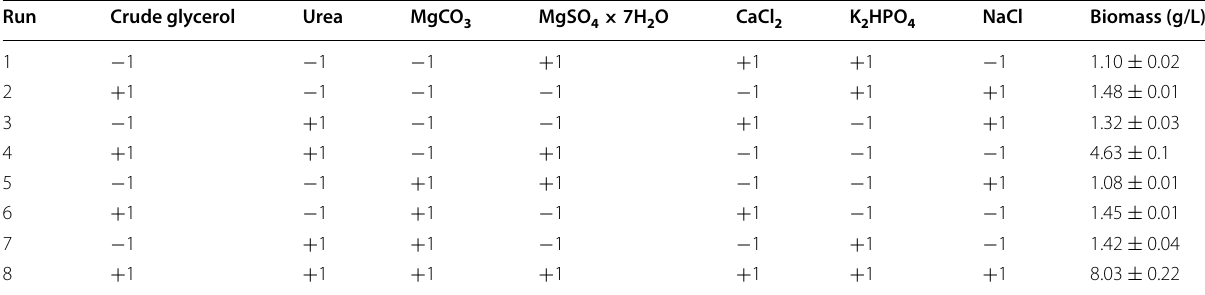
Table 1 Plackett–Burman design for seven variables with the corresponding experimental values of biomass concentra-